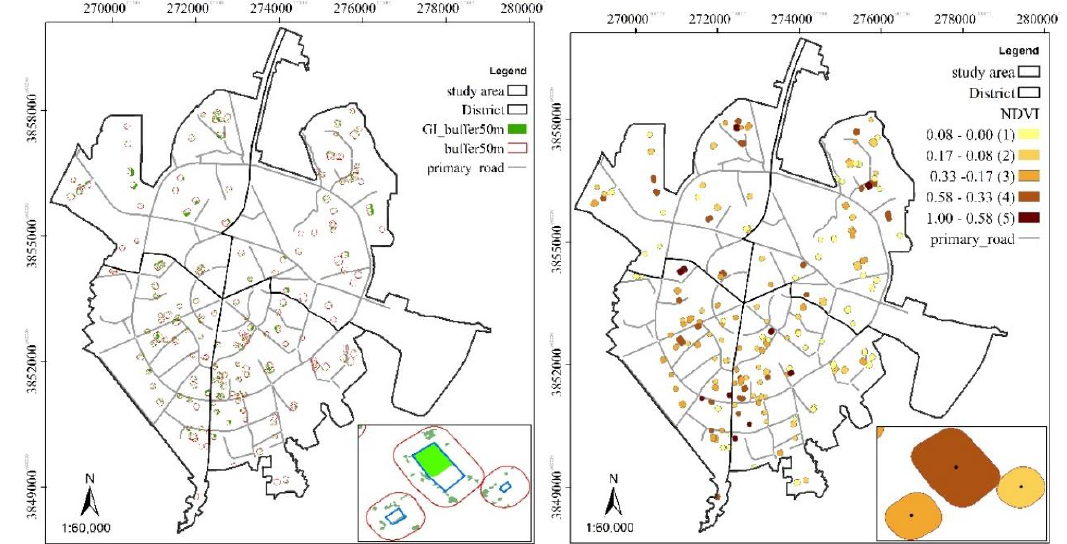
Fig. 3. Normalization of green cover index within range of 1-0 in buffer range in five